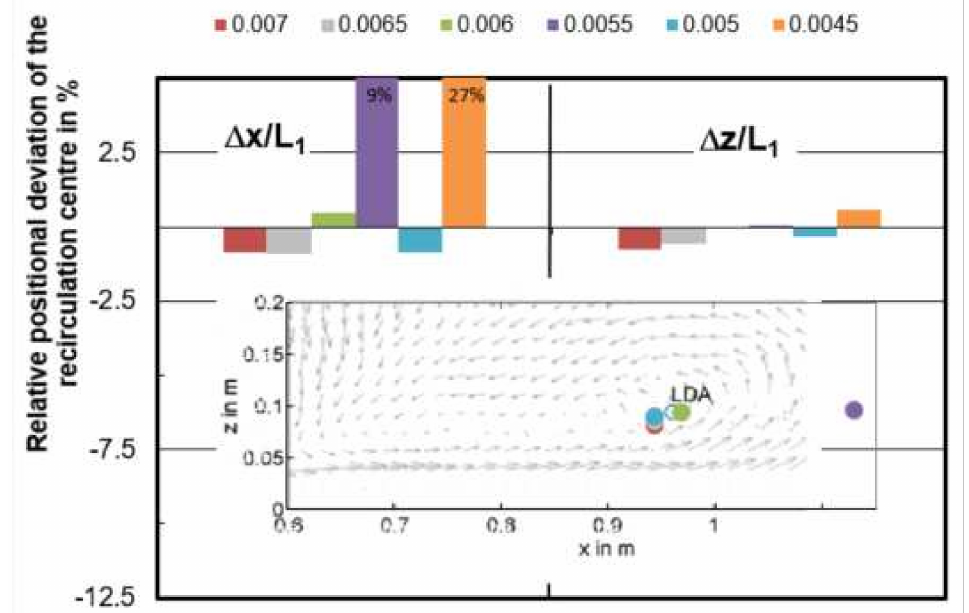
Figure 7. Relative positional deviation ∆ x/L 1 and ∆ z/L 1 of the recirculation center from CFD models with varied mesh size (y/L 1 =